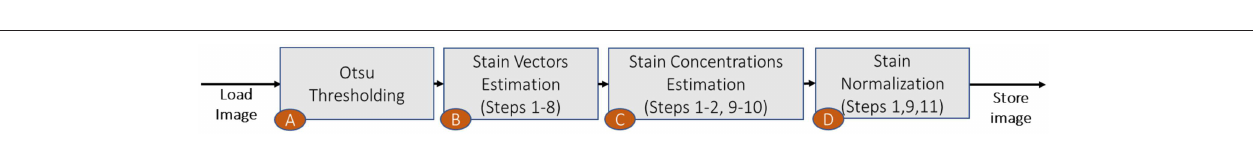
Figure 4 correspond to the optical density matrix (ODM